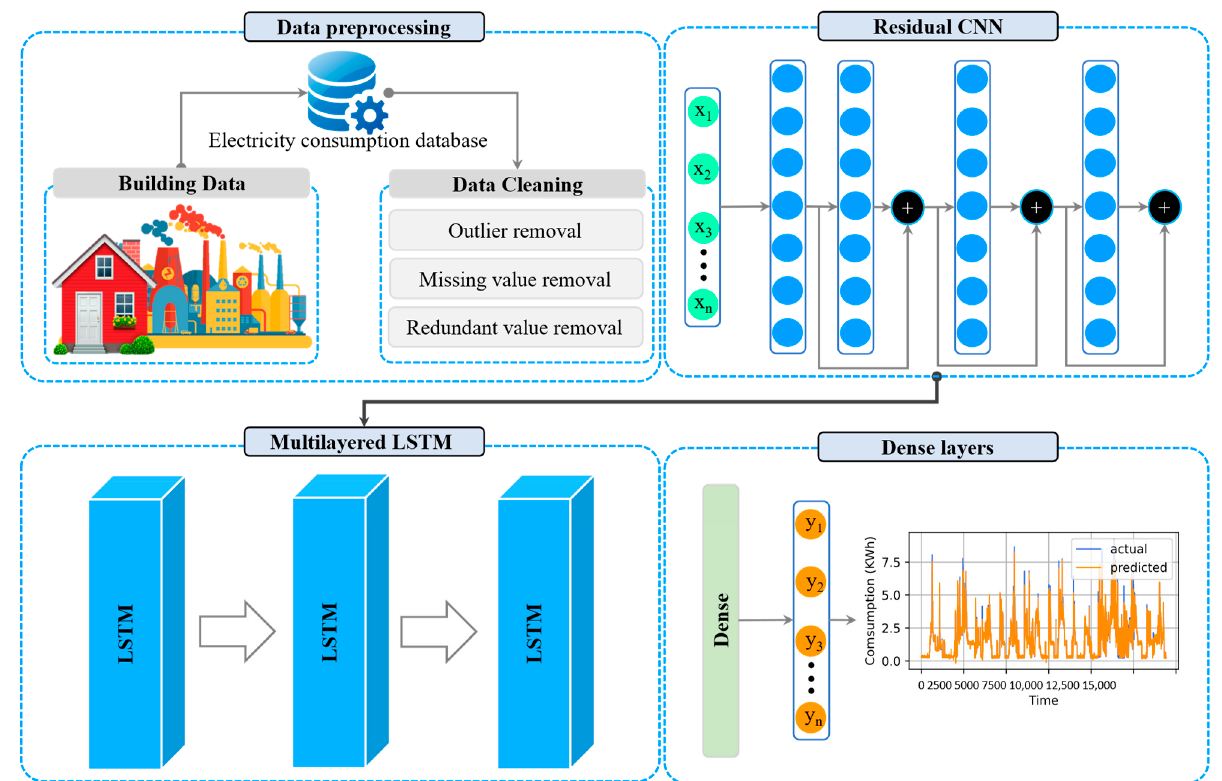
Figure 1. Proposed framework for electricity consumption forecasting.